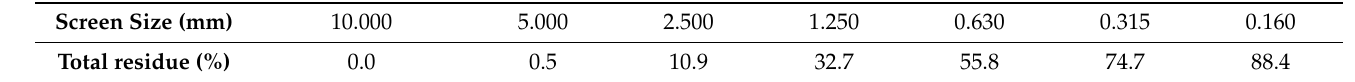
Figure 2. Particle size distribution of P.O. 42.5 ordinary Portland cement. Table 3. The gradation of fine aggregates used in this study.